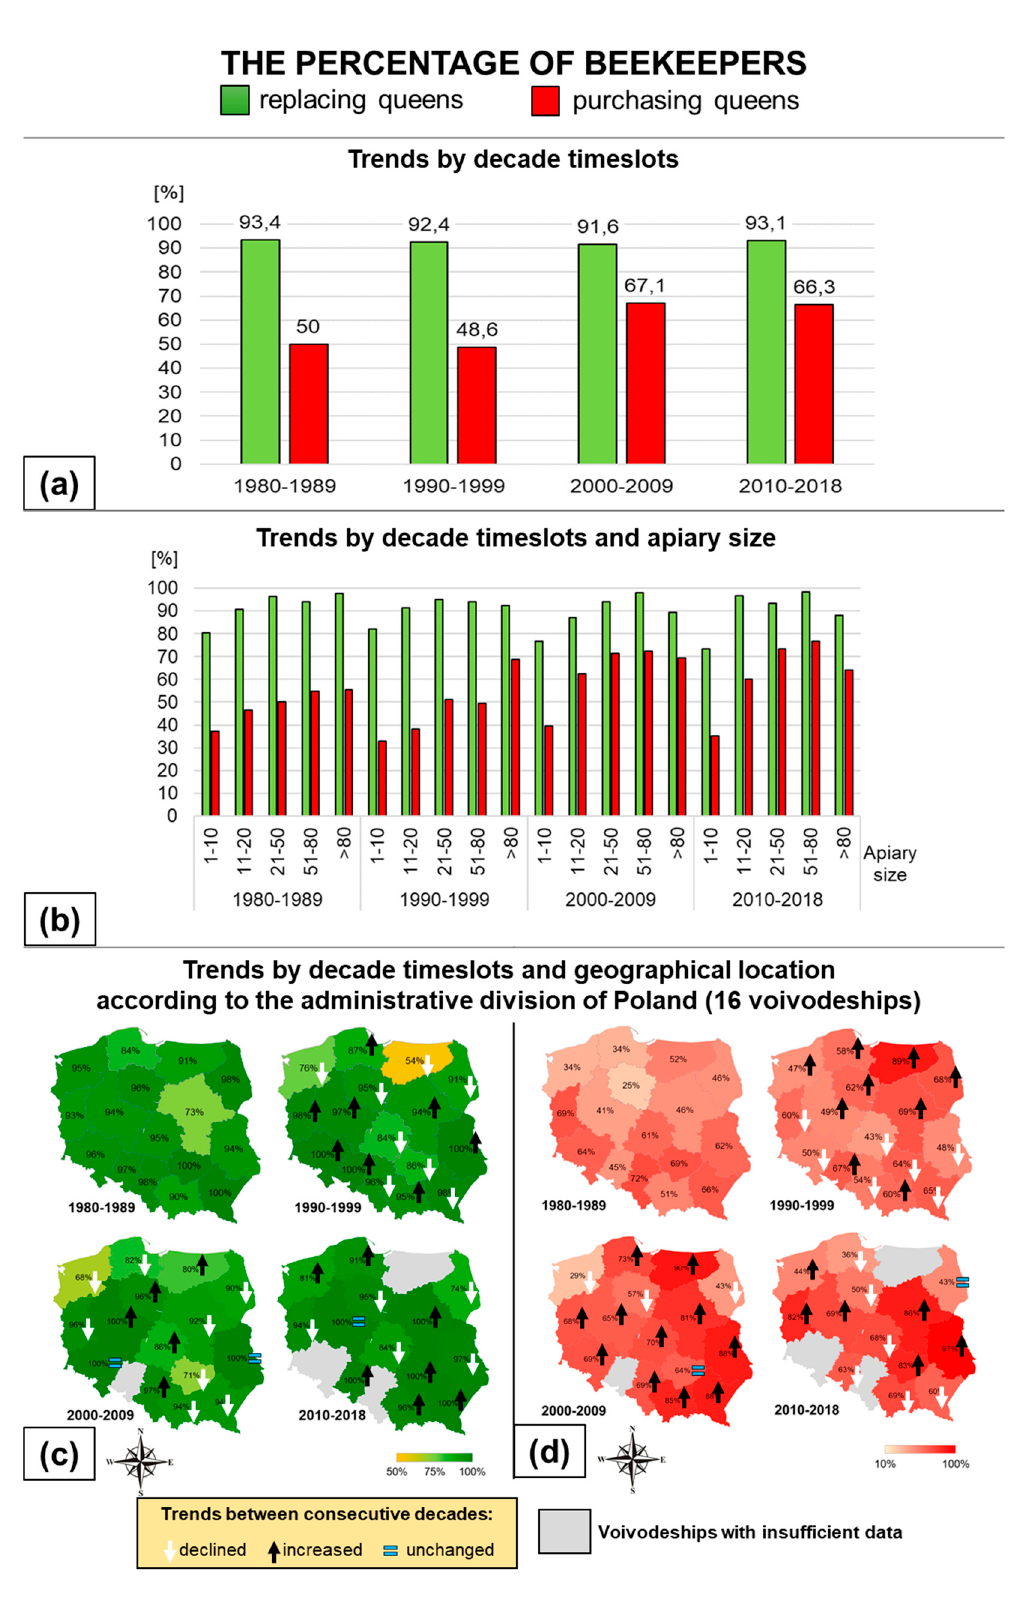
Figure 1. Percentage of beekeepers replacing queens, and percentage of beekeepers purchasing queens with regard only to beekeepers who replaced queens: ( a ) trends by decade timeslots; ( b ) trends by decade timeslot and apiary size; ( c ) trends by decade timeslot and geographical location for beekeepers replacing queens; ( d ) trends by decade timeslot and geographical location for beekeepers purchasing queens.